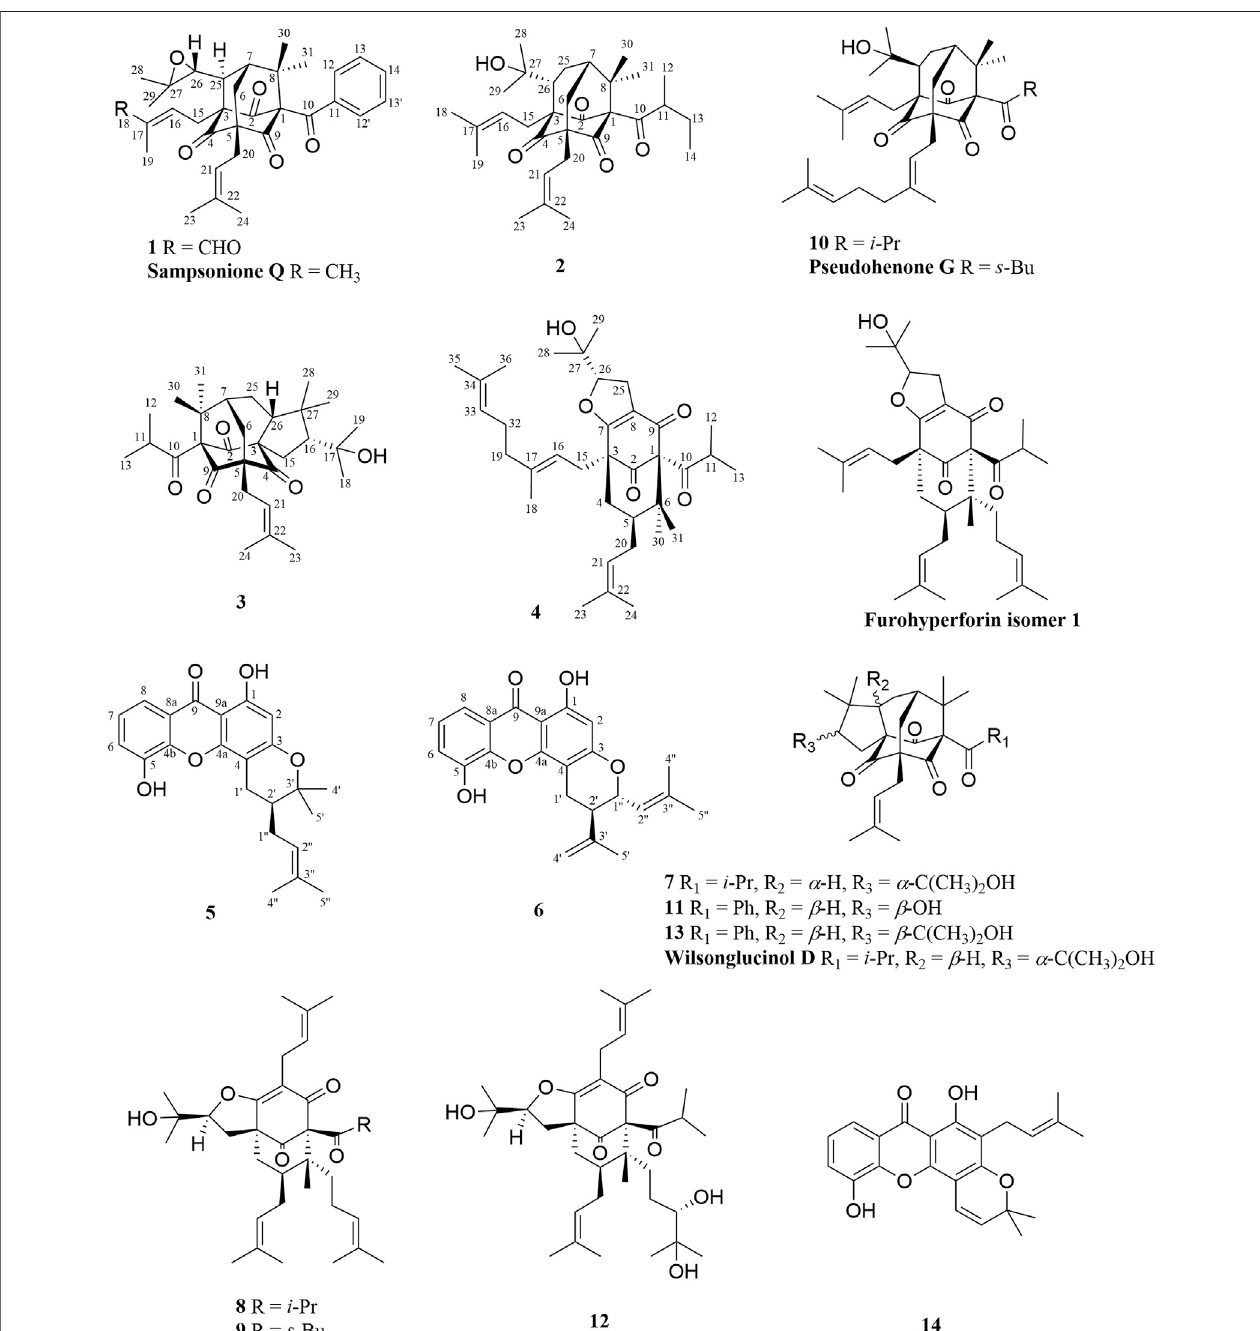
FIGURE 1 | Chemical structures of compounds 1-6